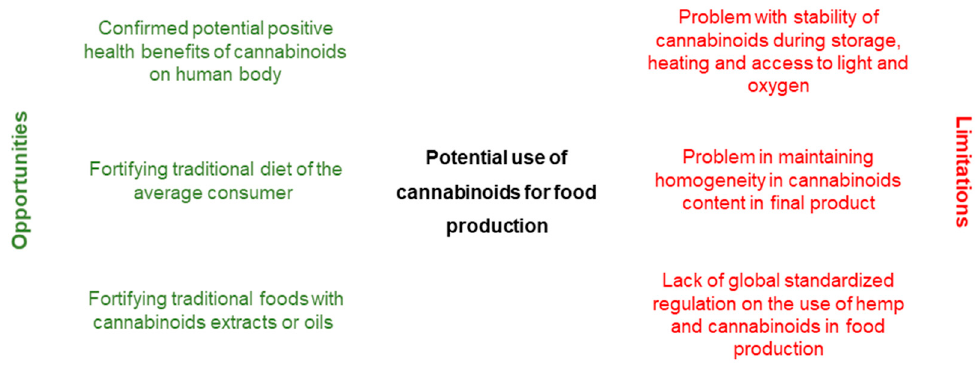
Figure 3. Major opportunities and limitations that may have an impact on the potential use of cannabinoids in food production [94–100].